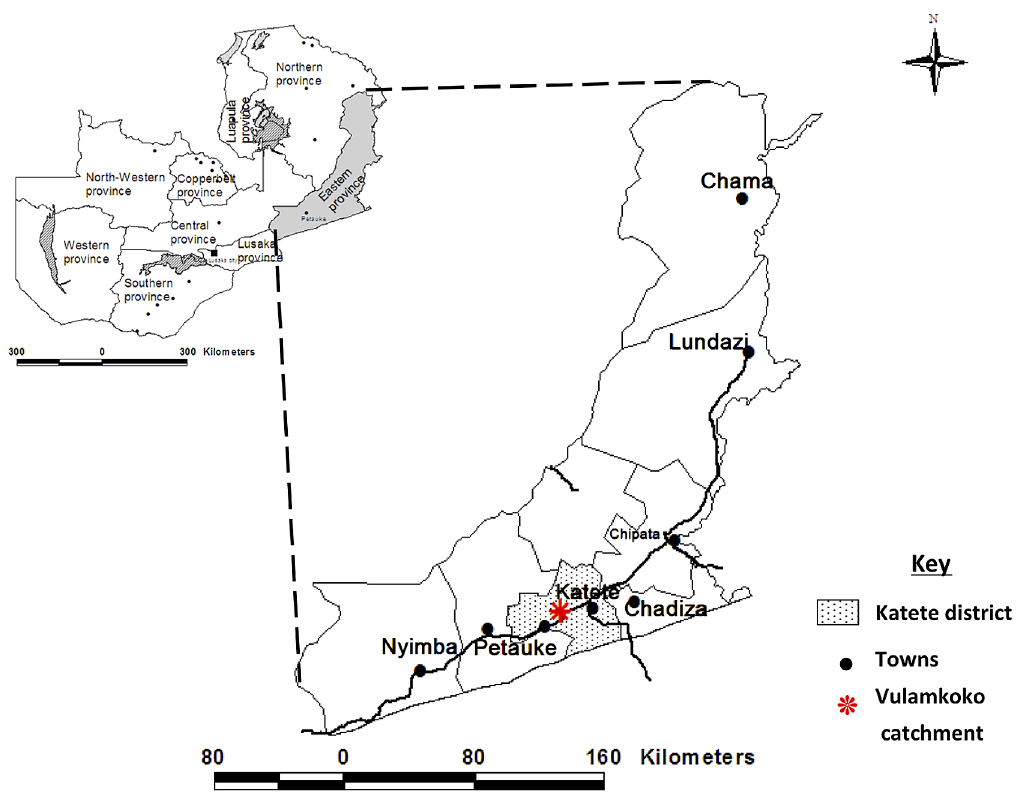
Figure 1. Map of Zambia showing the study area (Vulamkoko catchment) in Katete district of the Eastern province.